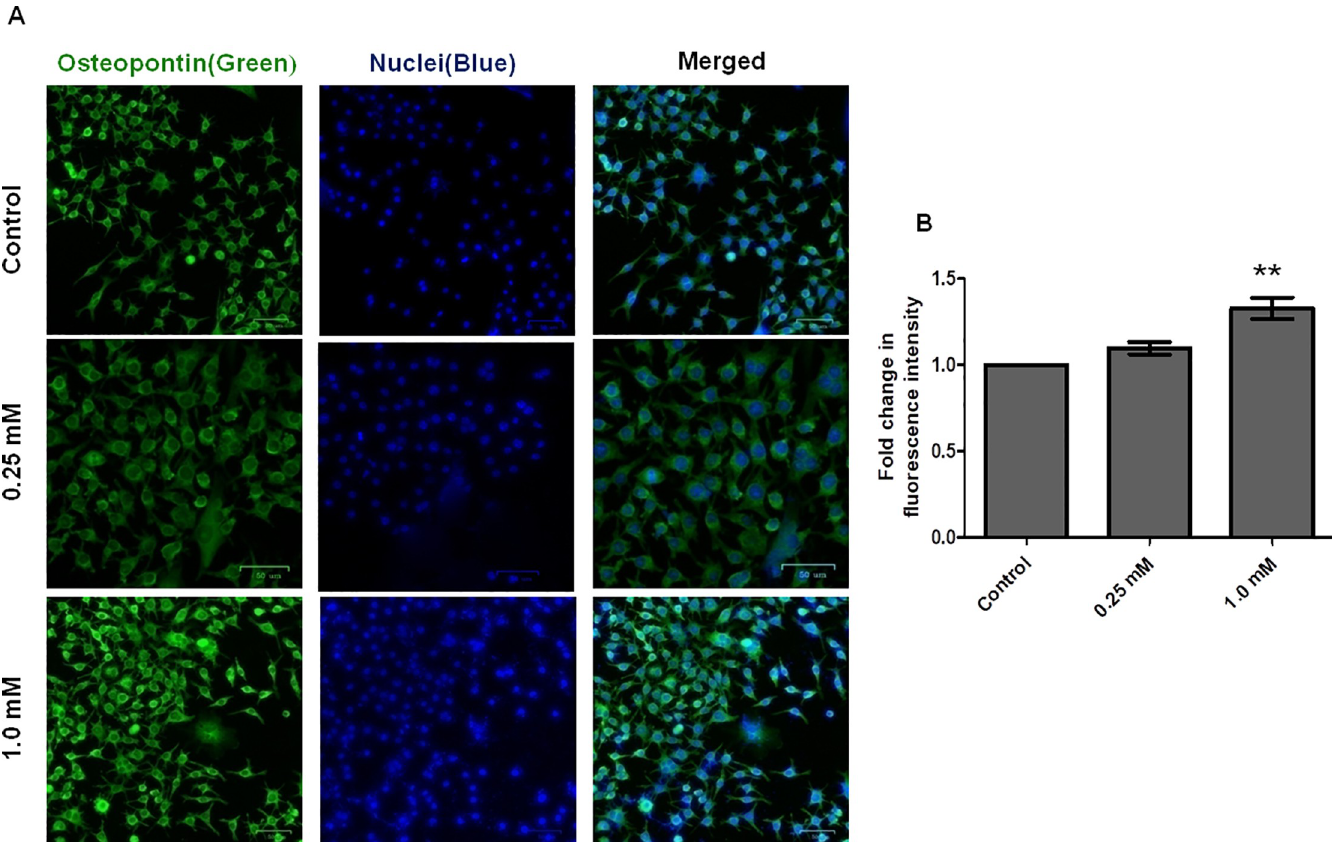
Fig 5. Osteopontin expression in response to calcium glucoheptonate treatment in MG-63 cells. Green fluorescence represents the expression of osteopontin and blue fluorescence indicates the nuclei counterstained with DAPI. (Scale bar: 50 μ m).